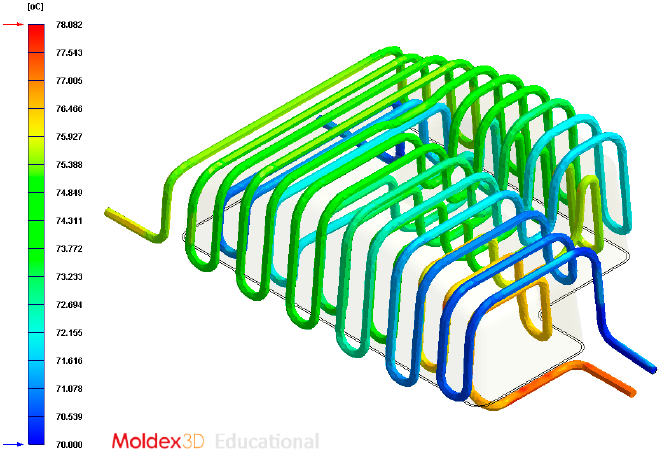
Figure 34. Temperatures ( ◦ C) of the coolant along the conformal cooling system, Case Figure 34. Temperatures (°C) of the coolant along the conformal cooling system, Case D. Figure 34. Temperatures (°C) of the coolant along the conformal cooling system, Case D. Figure 34. Temperatures (°C) of the coolant along the conformal cooling system, Case D.